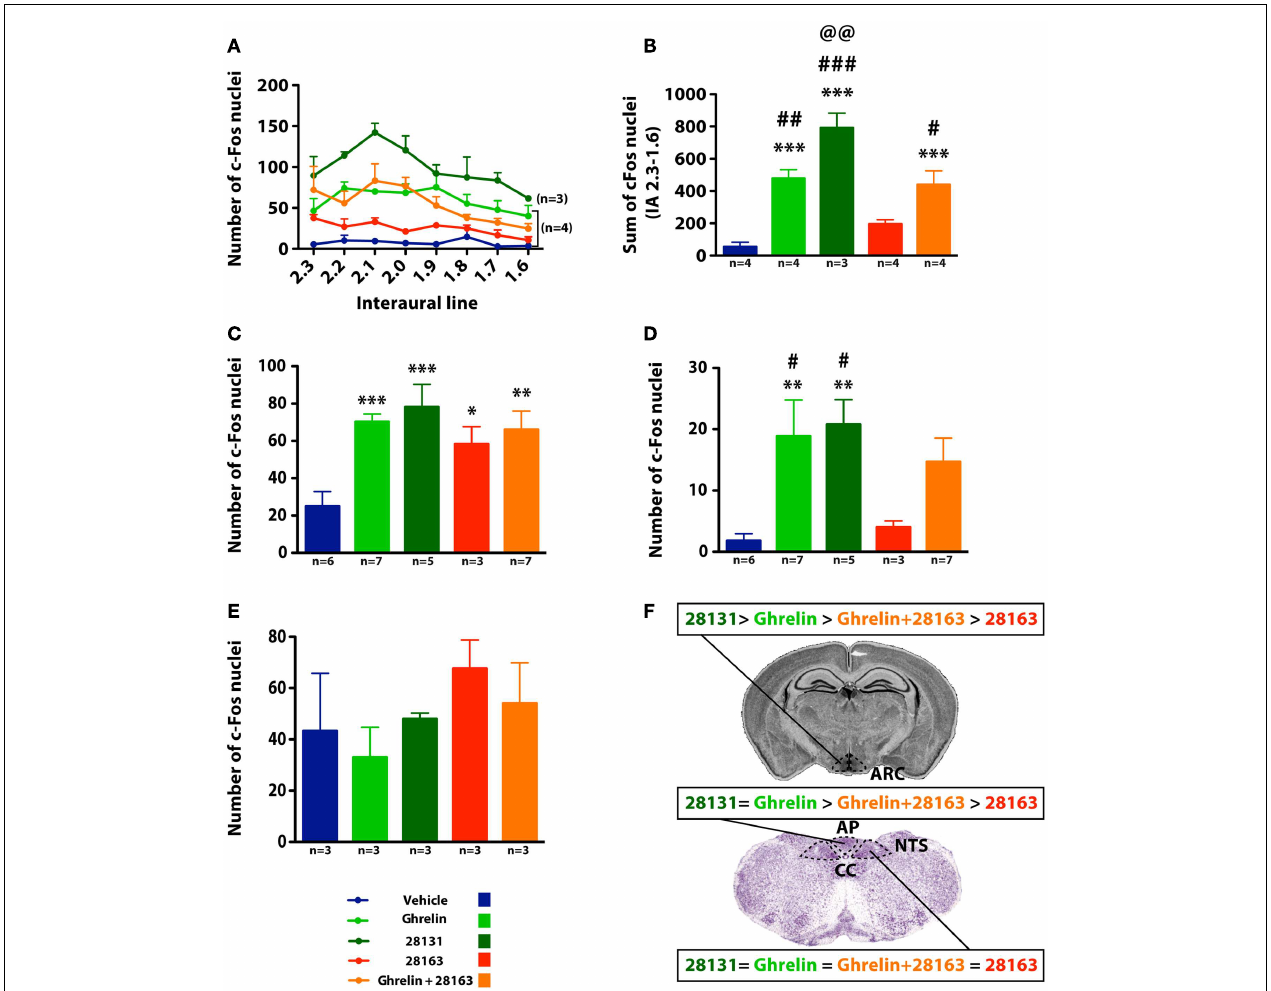
vehicle, # P < 0.05 vs. BIM-28163, ## P < 0.01 vs. BIM-28163, ### P < 0.001 vs. BIM-28163, @@ P < 0.01 vs. ghrelin + BIM-28163, Fisher PLSD post hoc test. (C,D) Number of cFos immunoreactive nuclei in the NTS and AP (3.7mm posterior to the interaural line). Data represent mean ± SEM. ANOVA shows an effect of treatment on the number of cFos nuclei in the NTS and AP. * P < 0.05, ** P < 0.01 and *** P < 0.001 vs. vehicle, # P < 0.05 vs. 28163, Fisher PLSD post hoc test. (E) Number of cFos immunoreactive nuclei in the VMH (2.5–2.3mm anterior to the interaural line). Data represent mean ± SEM. No significant effect of treatments is observed in theVMH. (F) Summary of the effect of the different BIM compounds on cFos activation in the ArcN, NTS, and AP. Cc, central